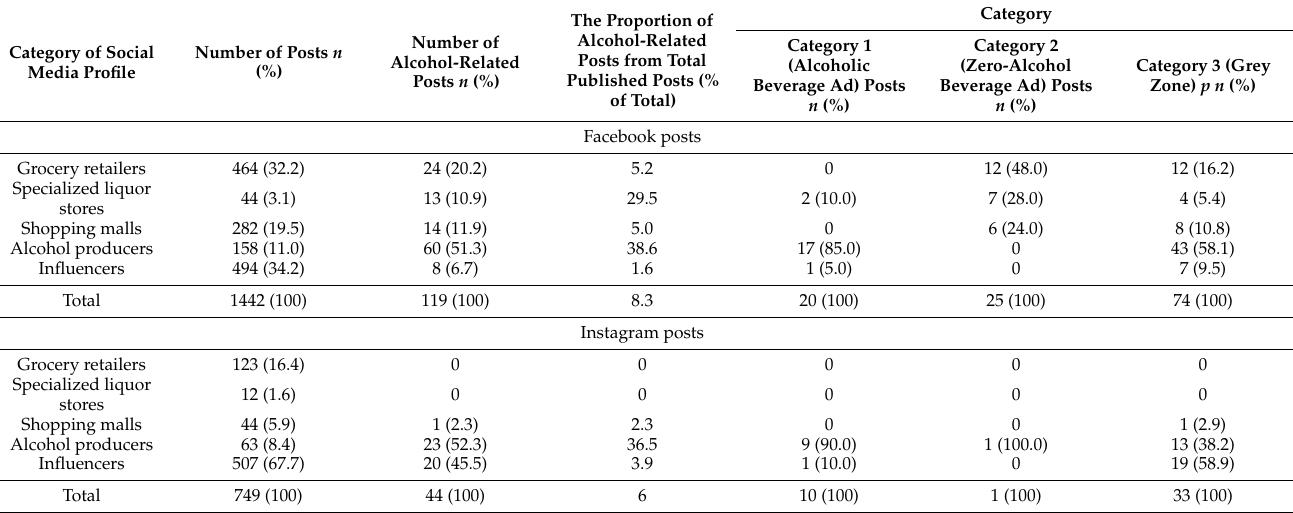
Table 4. Summary of key results by social media profile category ( n =